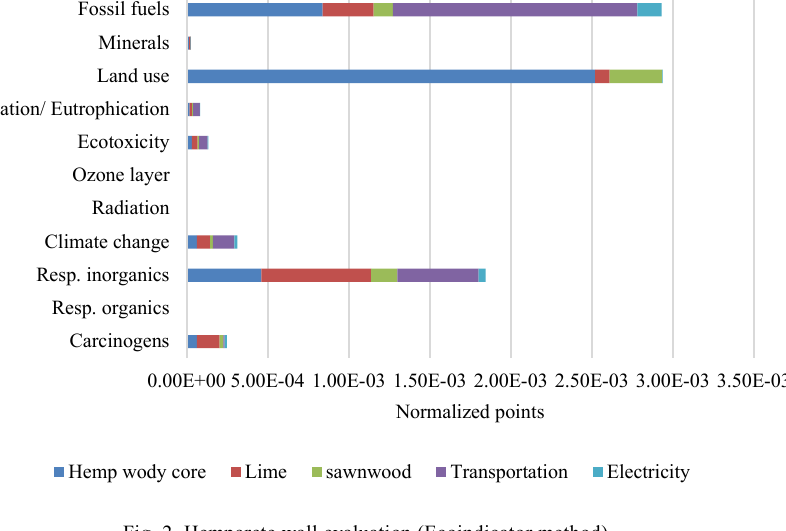
Fig. 2. Hempcrete wall evaluation (Ecoindicator